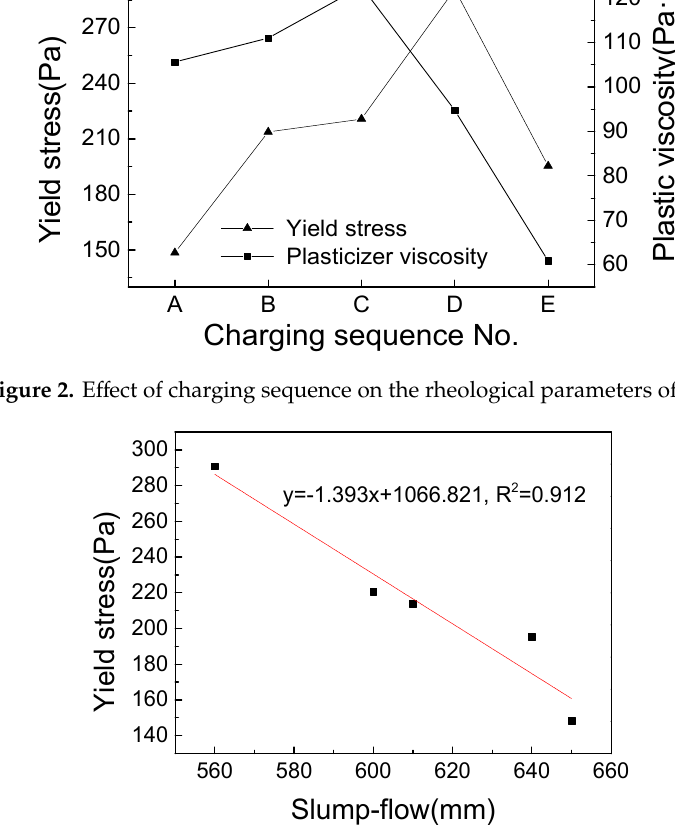
Figure 3. Relationship between the slump-flow and the yield stress of SCC.